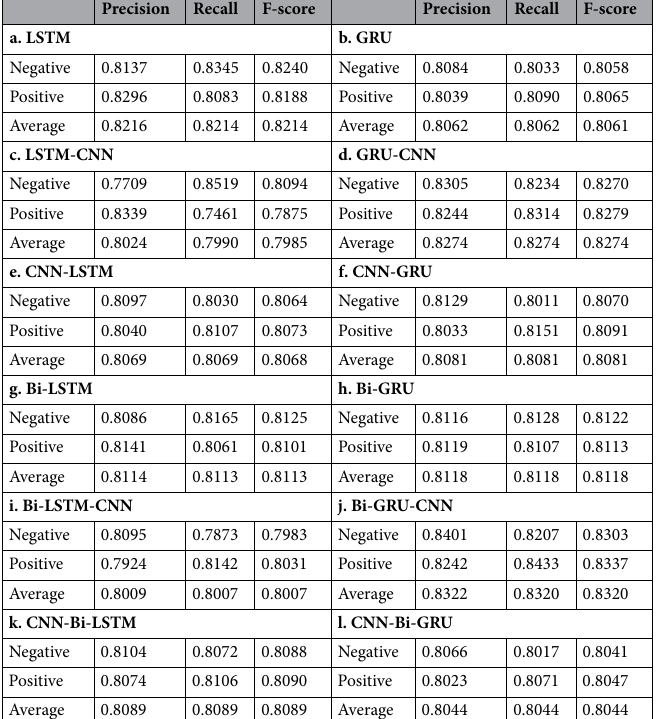
Table 11. Performance measures of the BRAD dataset.